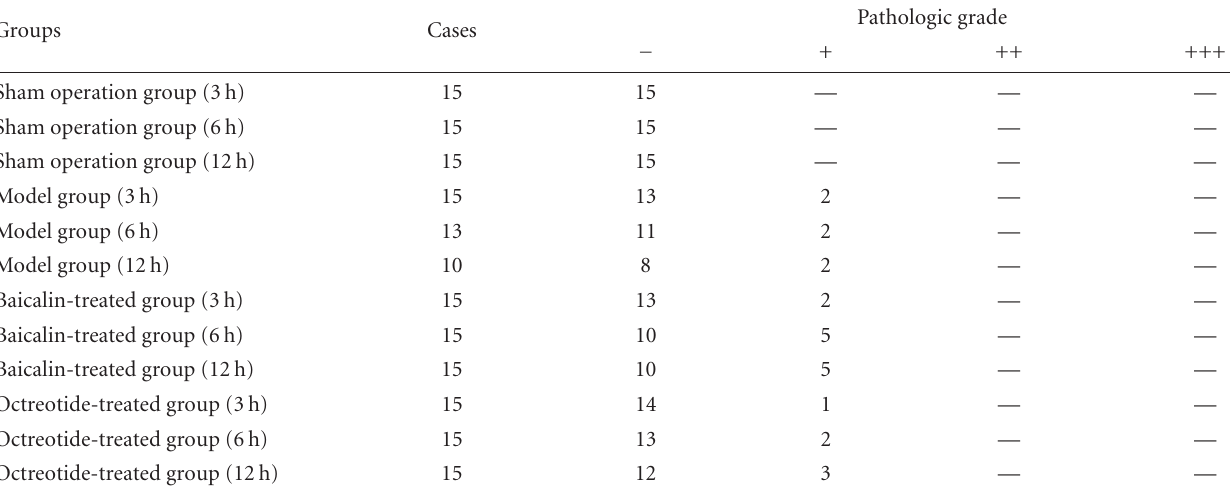
Table 9: Changes of Caspase-3 protein expression in all groups.